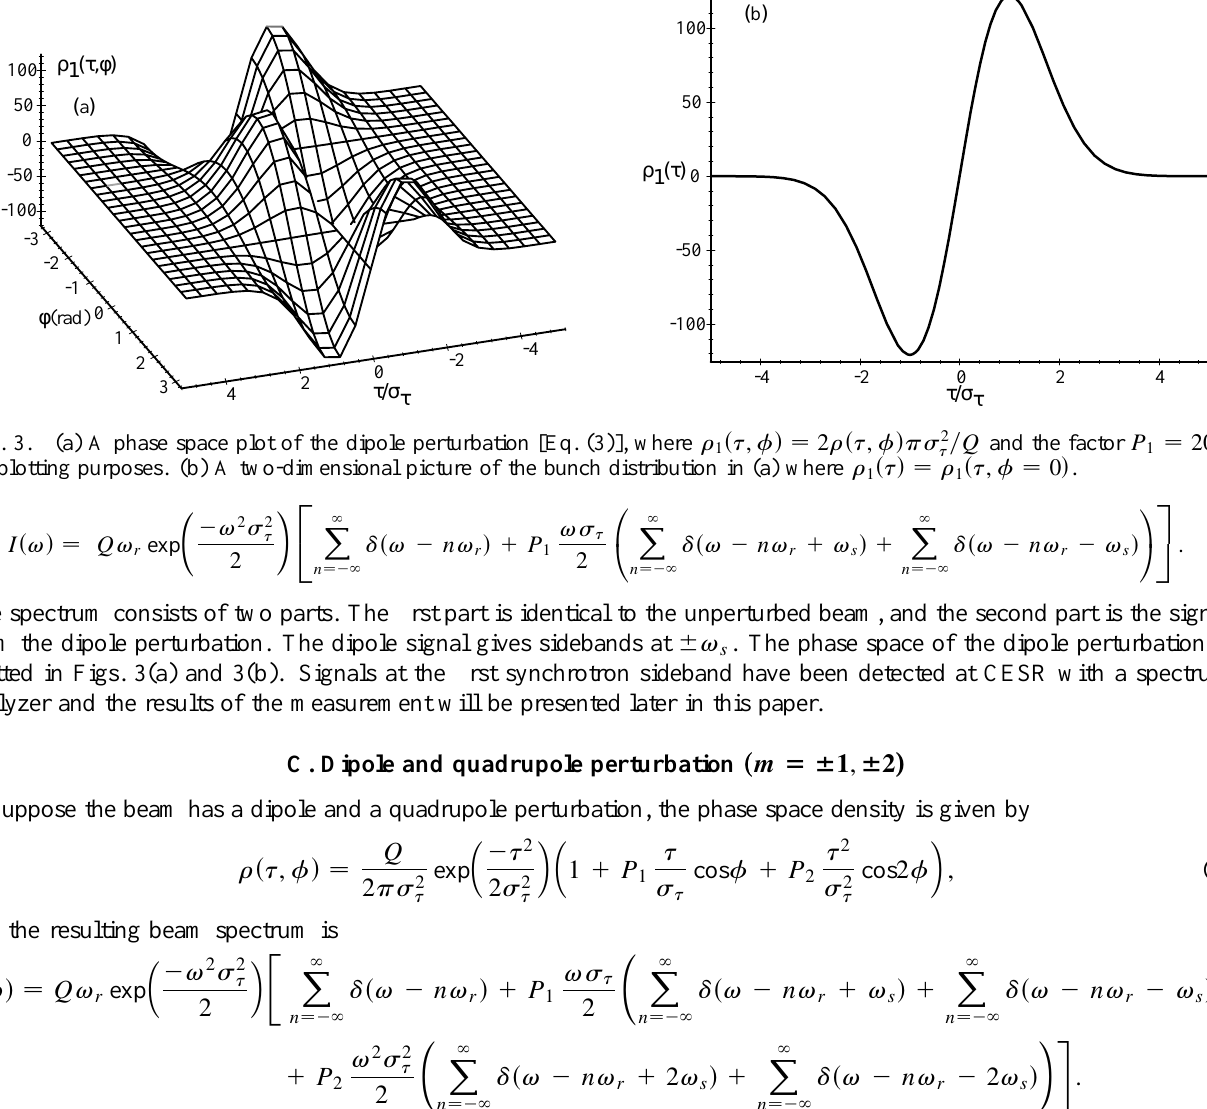
FIG. 3. (a) A phase space plot of the dipole perturbation [Eq. (3)], where r 1 (cid:1) t , f (cid:2) (cid:1) 2 r (cid:1) t , f (cid:2) ps 2